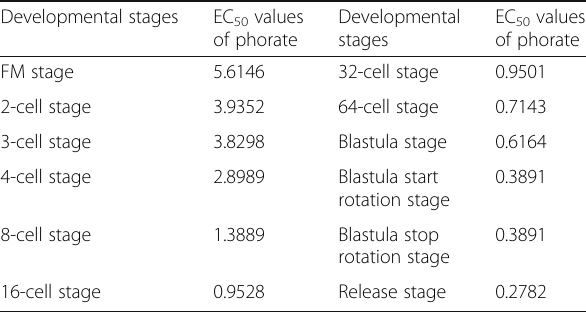
Table 1 Comparison of stage EC 50 values of phorate for different embryonic stages of H. elegans (temp. 28 ± 0.2 °C, salinity